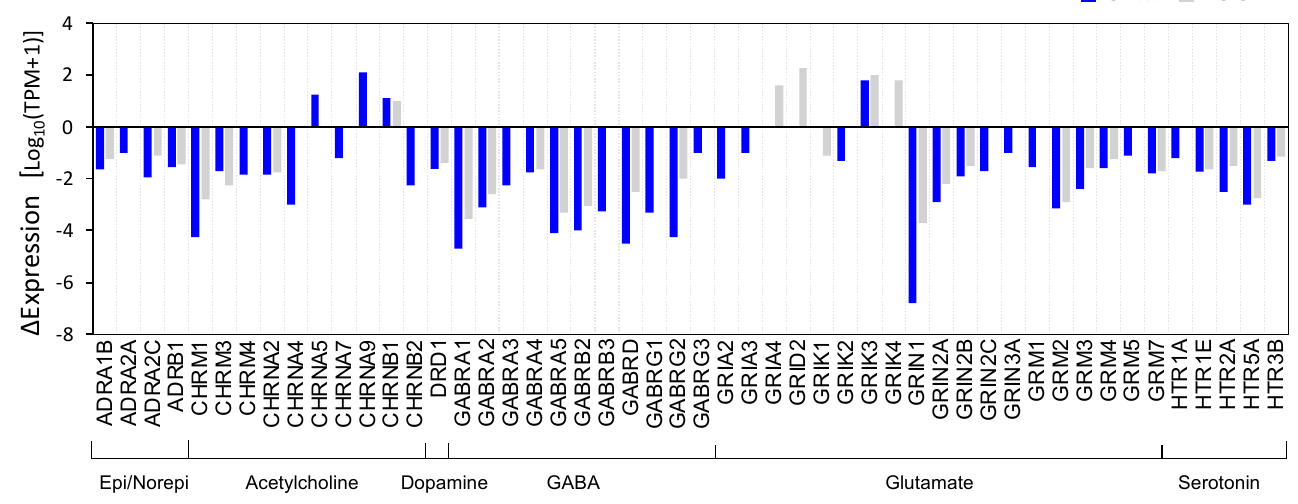
Figure 2. Expression of NTR genes in normal and cancer tissues. The bar plots represent the “ ∆ Expression = median expression (tumor) − median expression (normal)”. On the x-axis are the gene symbols. Both GBM (N = 163) and LGG (N = 518) were matched with normal brain samples (N = 207).